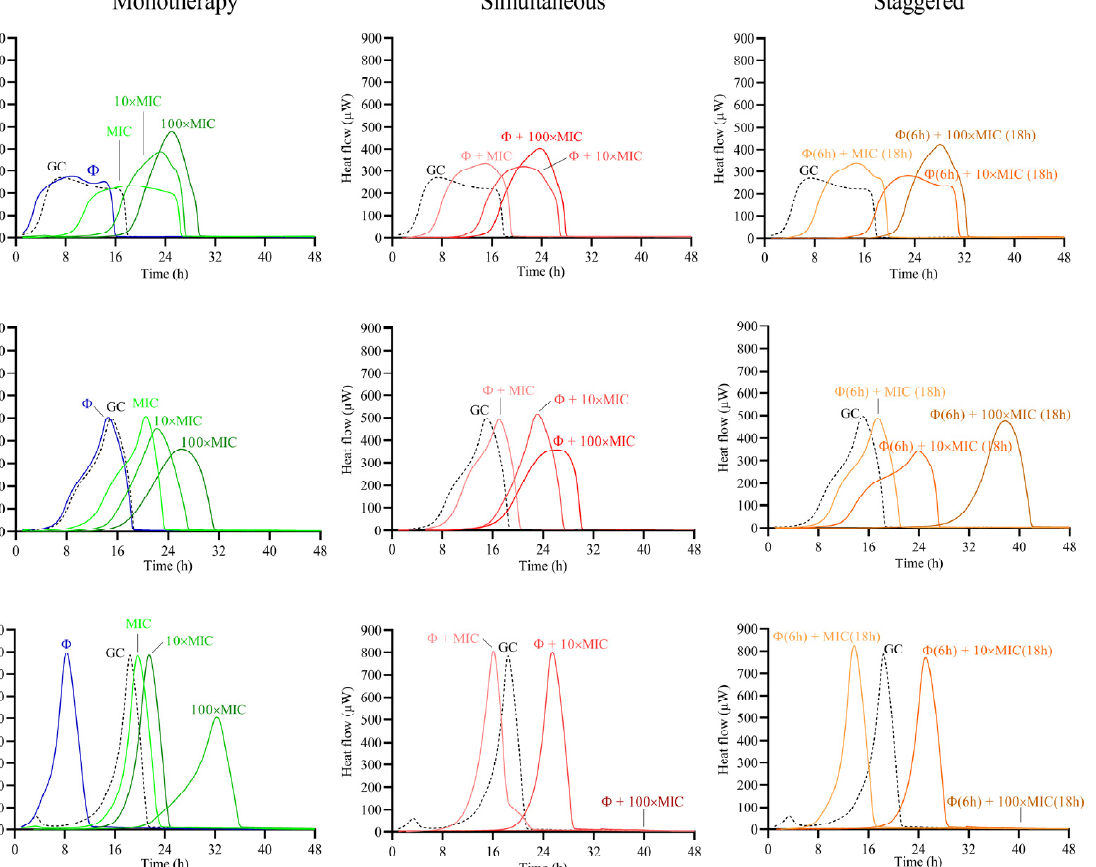
Figure 6. Calorimetric curves. Monitored heat flow ( μ W) of S. maltophilia ( A ) STM-1, ( B ) STM-19, ( C ) STM-33 and ( D ) STM-38 biofilms treated with CUB19 ( Φ at 10 8 PFU/mL) or levofloxacin at dif- ferent concentrations (1×, 10× or 100× MIC) as monotherapy (left column), or by simultaneous (mid- dle column) and staggered (right column) phage-antibiotic combinations ( Φ + levofloxacin). Each curve shows the heat flow produced over time by viable bacteria in the biofilm after 24 h of treat- ment. GC represents the growth control sample not exposed to any antimicrobials. Data of a repre- sentative experiment are reported.